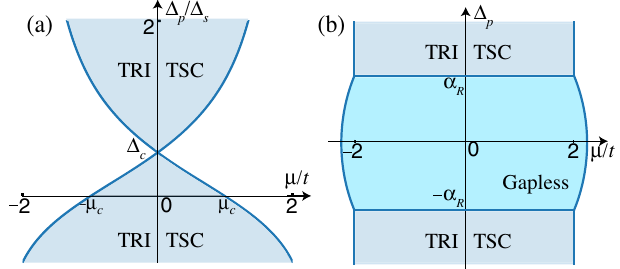
FIG. 2. Topological phase diagram of the effective 1D model. (a) RALD embedded in s -wave superconductors with mixed- parity s -wave and d y -vector p -wave pairing. (b) Nodal RALD embedded in d -wave superconductors with purely d x -vector p -wave pairing. The TRI TSC becomes gapless in the region − α < Δ < α R p R and bounded by the curved lines from the trivial SC